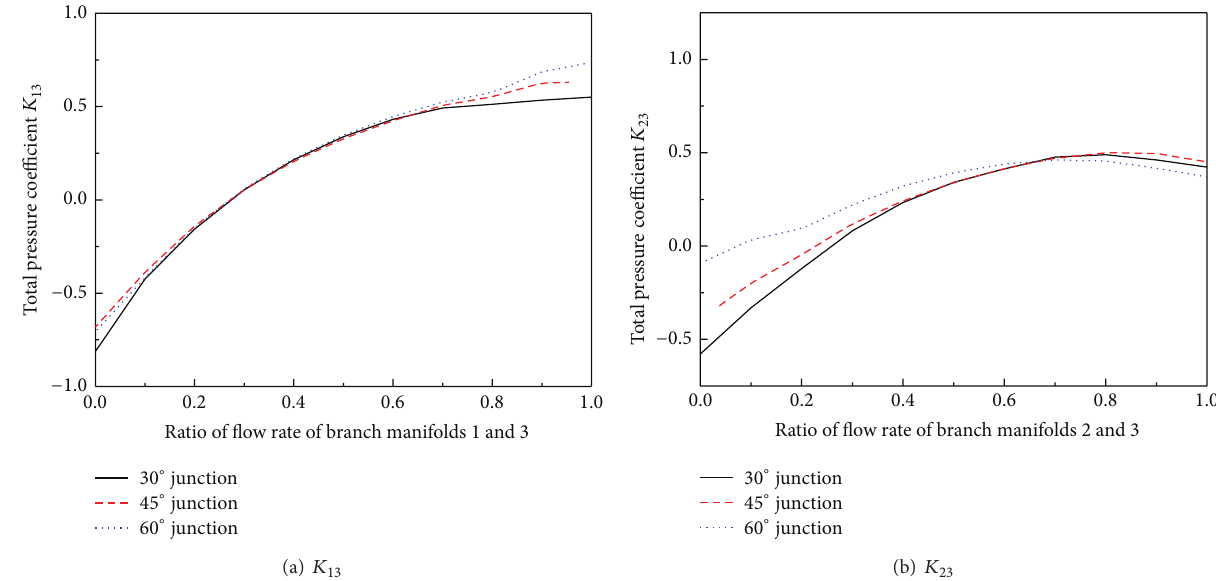
Figure 15: Comparison of calculated total pressure loss coefficient with various lateral branch